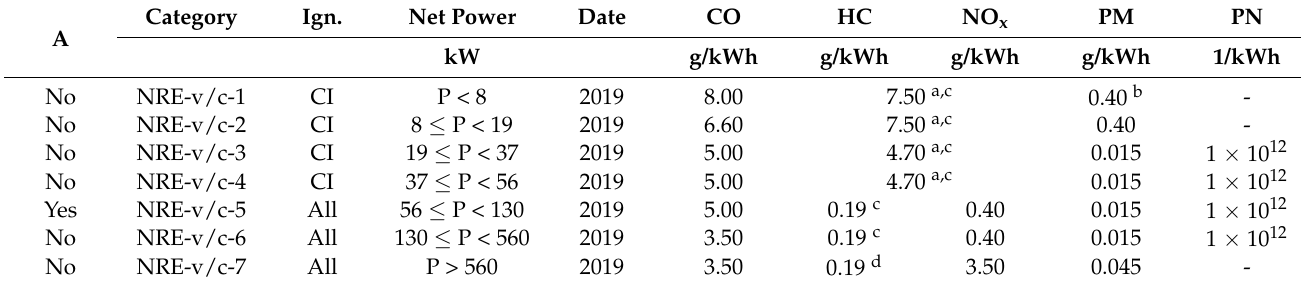
Table 4. Stage V emission standards for non-road engines (NRE), where: A—the availability of selected categories of engines used in fans for rescue operations on the European market